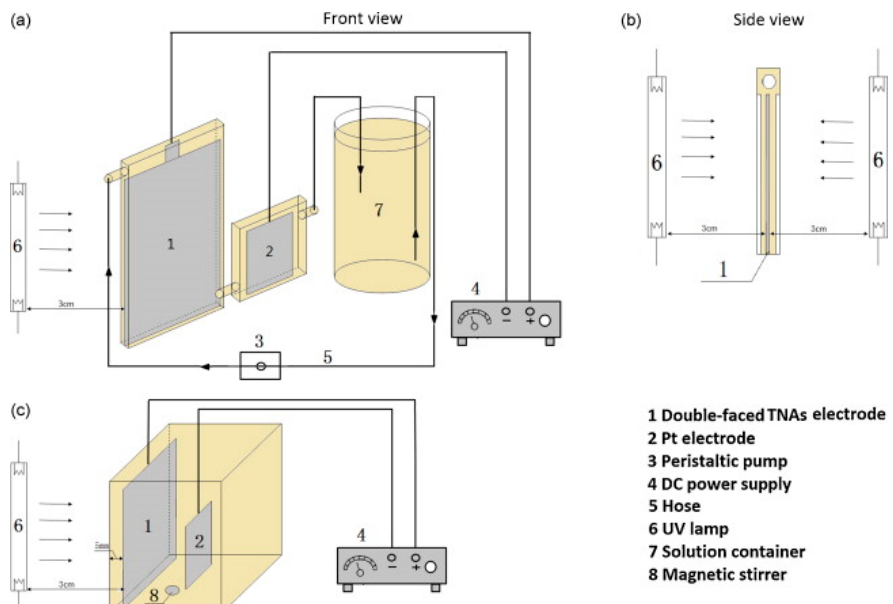
Figure 15. Schematic diagram of the TNA-based thin-layer PEC reactor ( a , b ) and the conventional PEC reactor ( c ). (Reproduced with permission from [71]: Bai, J.; Liu, Y.; Li, J.; Zhou, B.; Zheng, Q.; Cai, W. A novel thin-layer photoelectrocatalytic (PEC) reactor with double-faced titania nanotube arrays electrode for effective degradation of tetracycline. Appl. Catal. B 2010 , 98 , 154–160, doi:10.1016/j.apcatb.2010.05.024. Copyright (2010), Elsevier (Amsterdam, The Netherlands)).